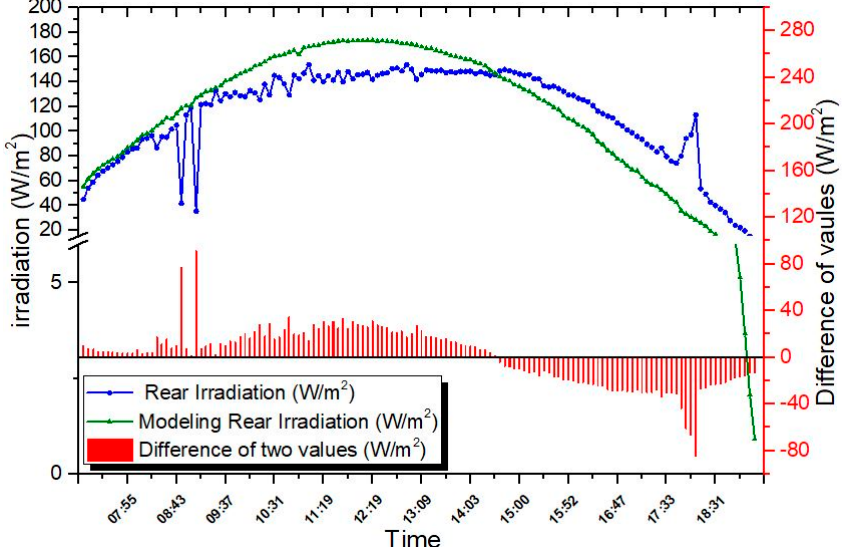
Figure 19. The difference in the values of the irradiance measured through the rear pyranometer and predicted through the modeling.